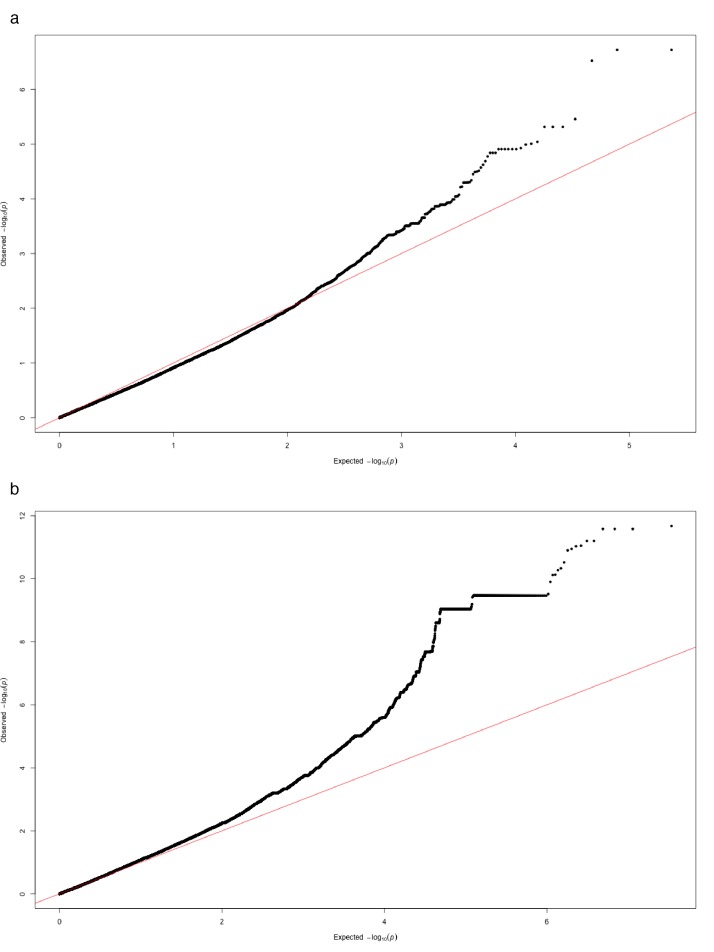
Quantile-quantile plot of association p-values.For fast-lmm results on (a) SNPs passing quality filters and (b) k-mers of all lengths passing quality filters.